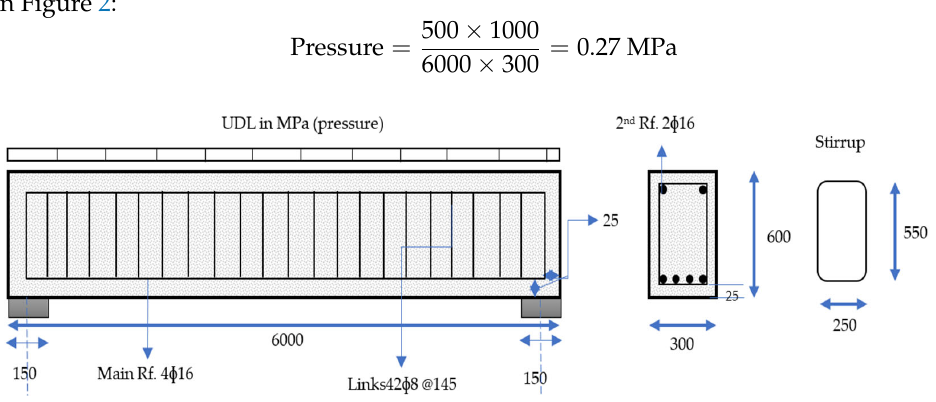
Figure 2. Schematic view of the modeled beam. Note: units in mm.